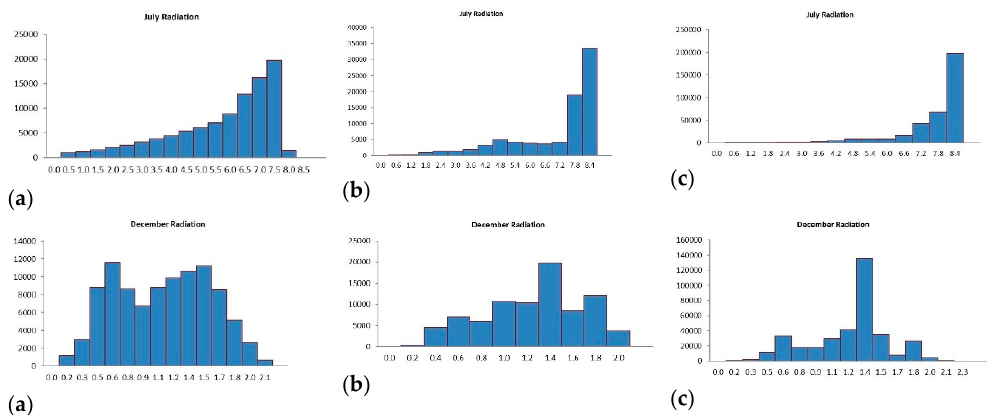
Figure 3. Histograms representing the radiation values in July and December in ( a ) zone 1, ( b ) zone 2, and ( c ) zone 3.